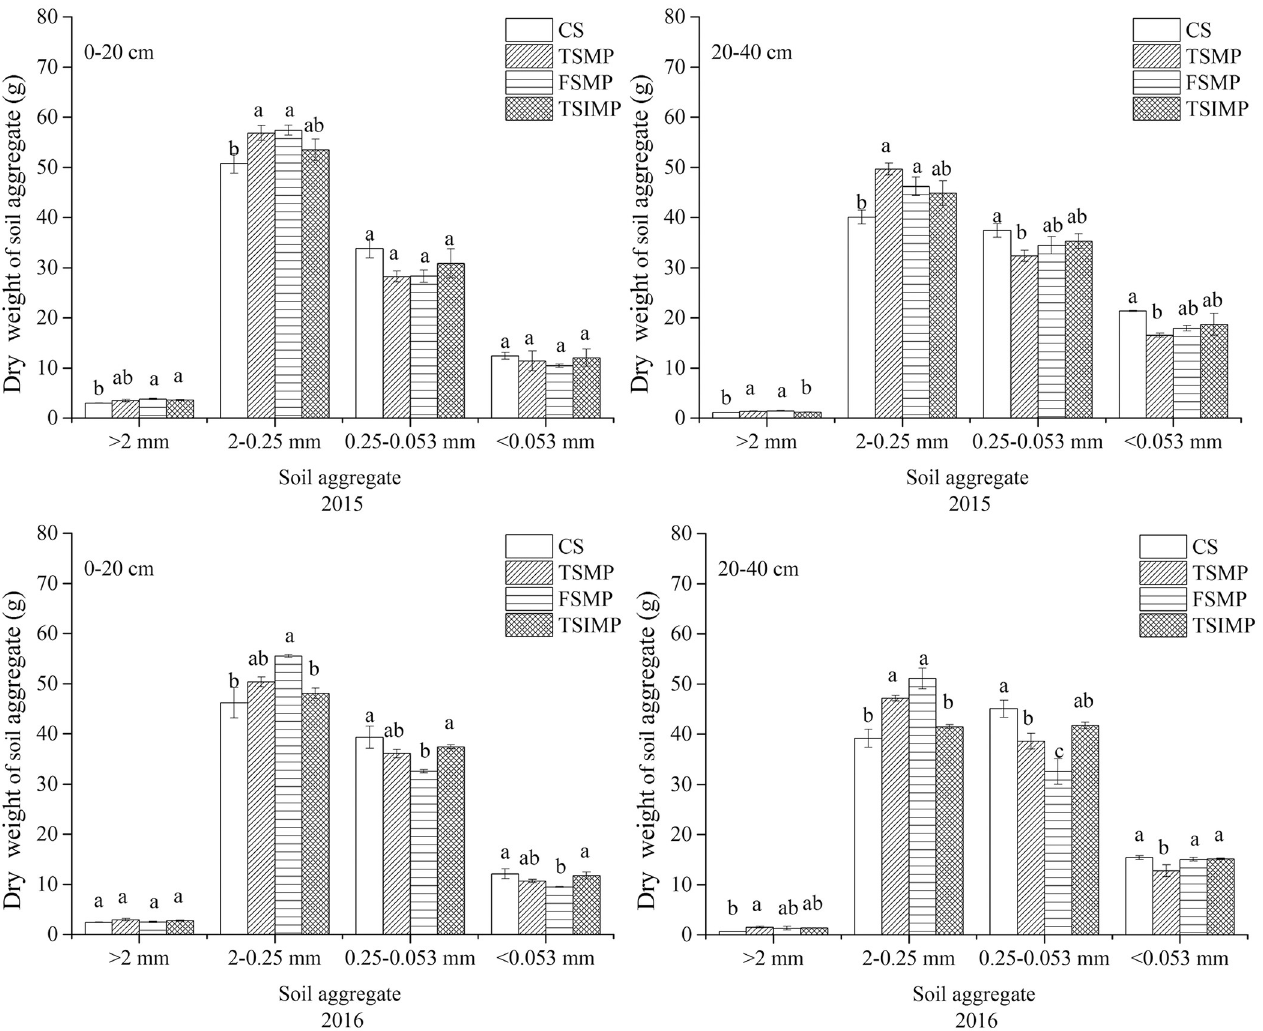
Fig 5. Effects of soil mixing on the water-stable aggregate of Albic soil. Different lowercase letters indicate significant differences between samples ( P < 0.05). Bars represent standard errors (n = 3).